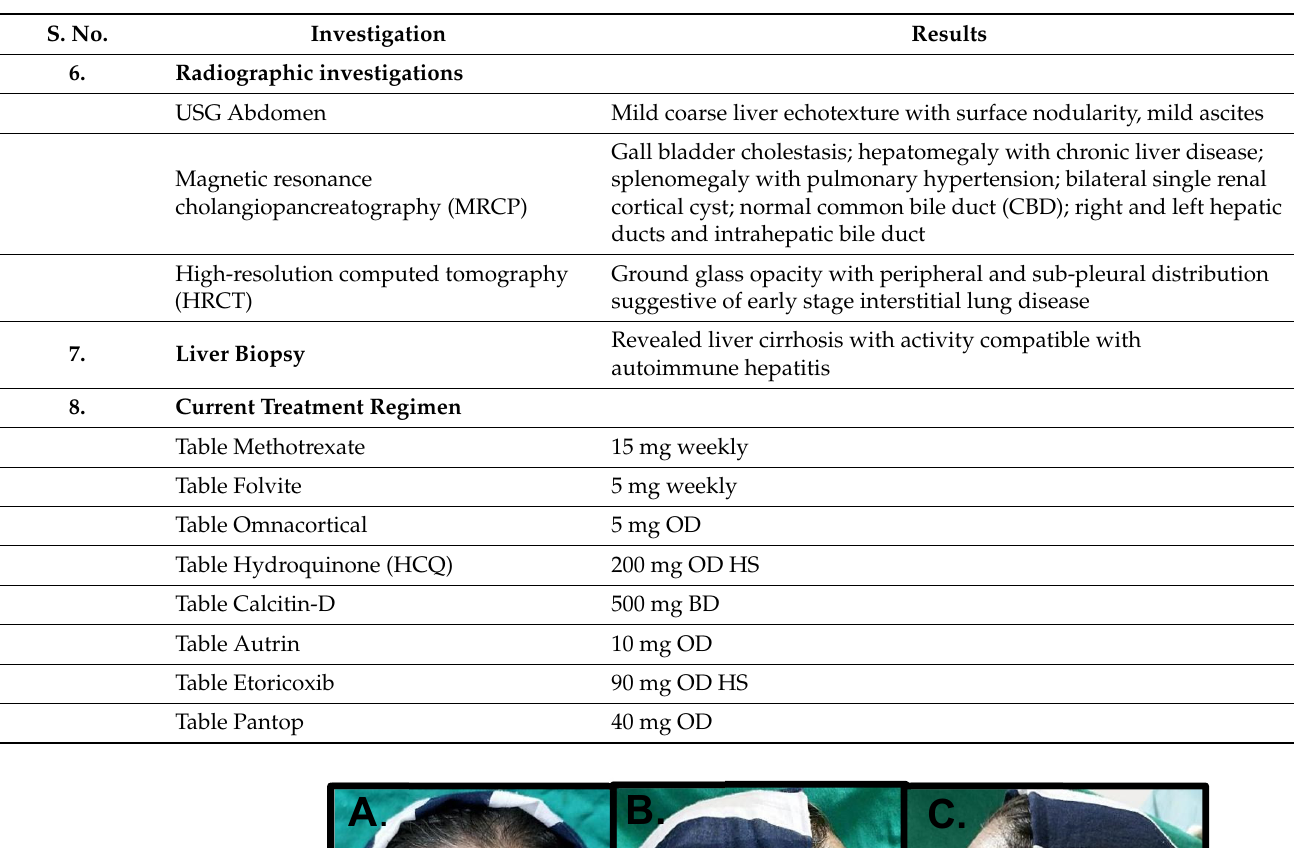
Table Calcitin-D